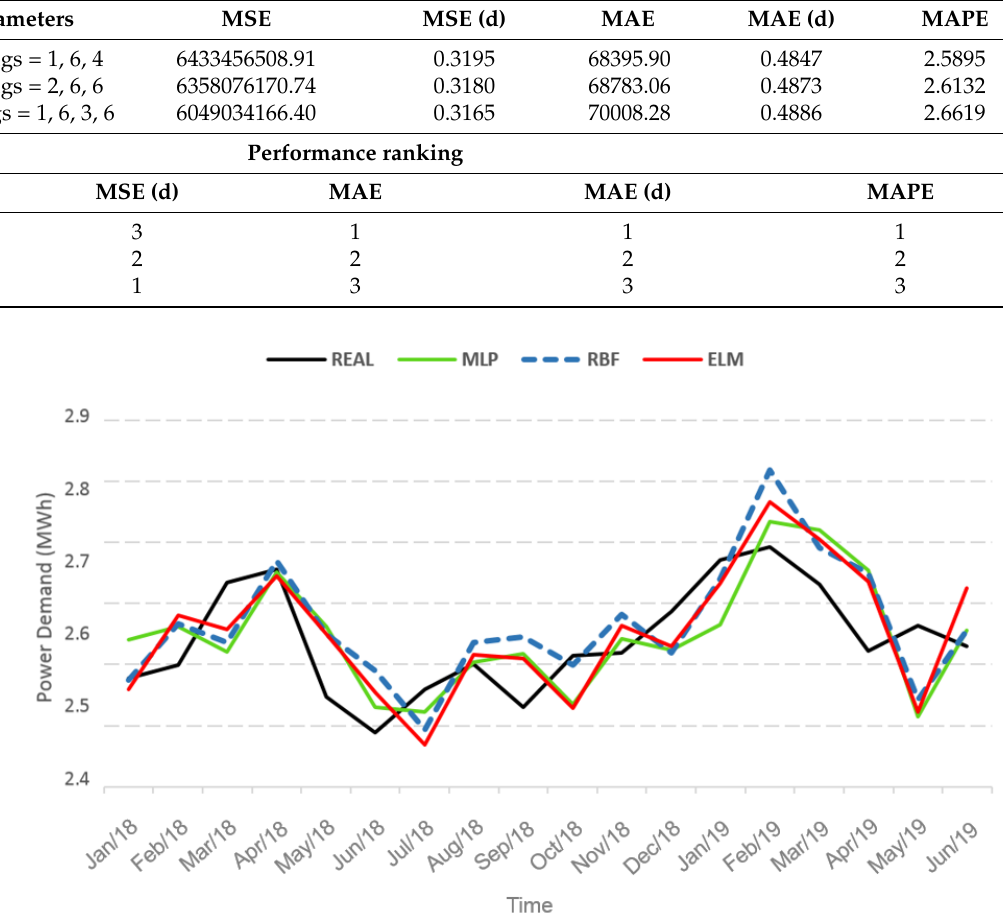
Figure 11. Graph comparing actual data with data predicted for six steps ahead, using MLP, RBF, and ELM.